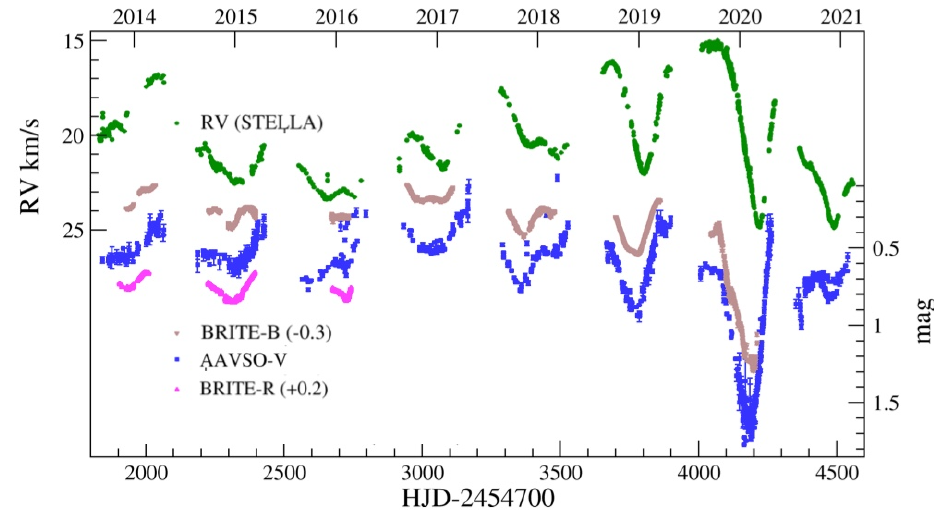
Figure 16. Comparison of light and RV variations of Betelgeuse. From top to bottom: STELLA RV data, BRITE-blue, AAVSO-V absolute photometry, and BRITE-red photometry. Error bars on BRITE magnitudes and on STELLA RV are too small to be